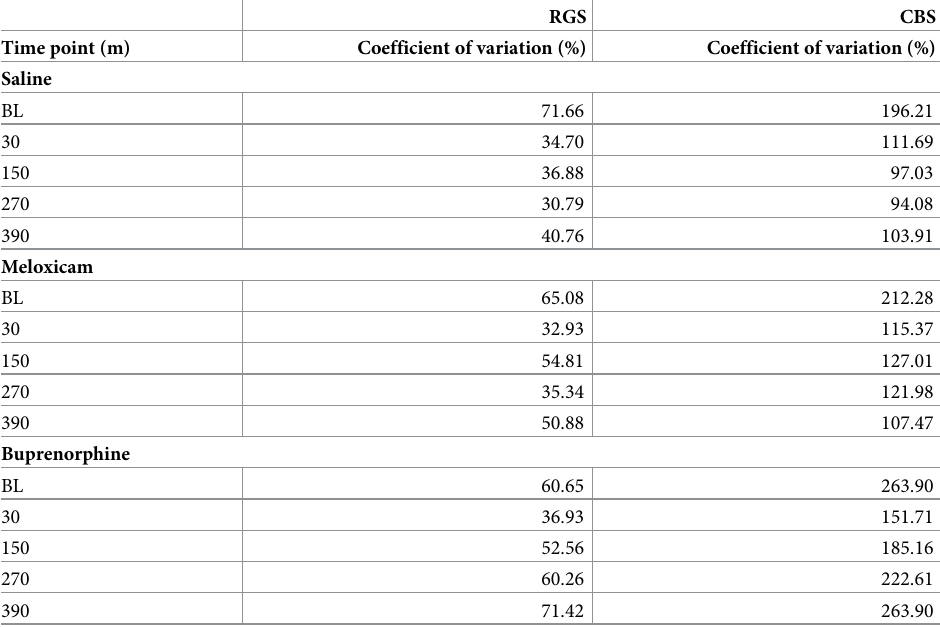
Table 3. Coefficients of variation for RGS and CBS